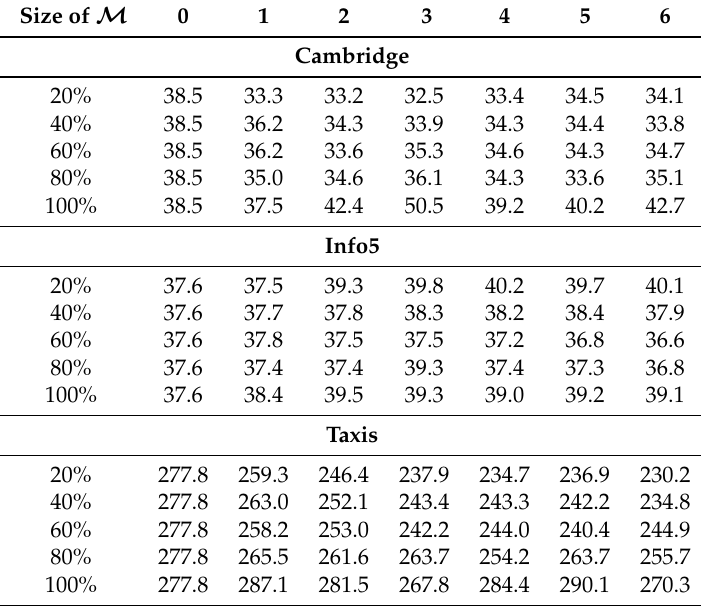
Table 3. Overhead ratio with centrality mix nodes.